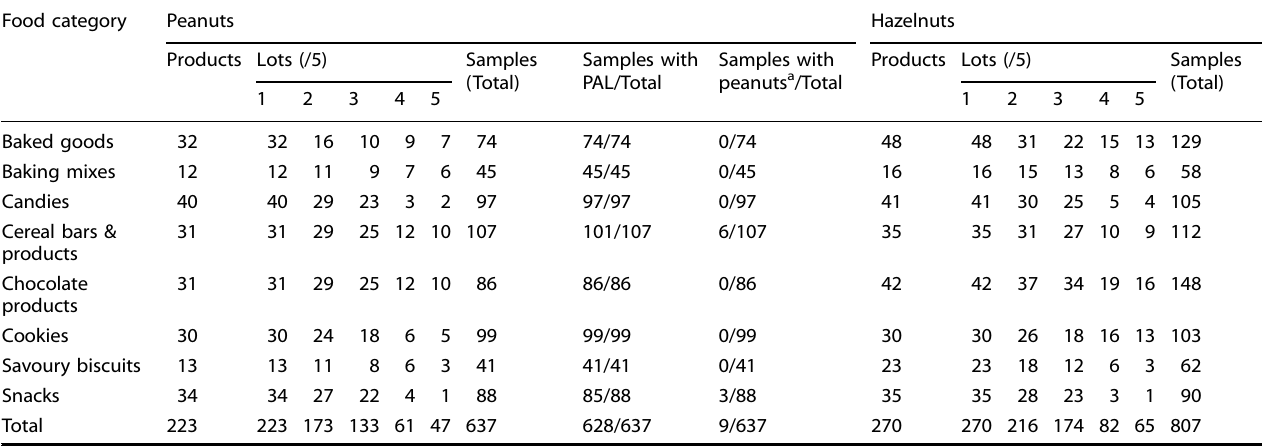
Table 1. Summary of purchased products per allergen and by food category with PAL or peanuts present as a minor ingredient. Food category